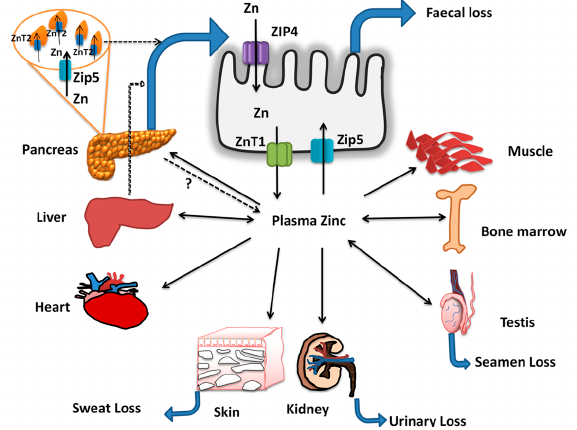
Figure 2. Zinc absorption and homeostasis: Dietary zinc and zinc excreted through pancreatic secretions are absorbed via ZIP4 at the apical surface of the enterocyte and are transported into circulation via ZnT1. The zinc in the plasma bound to albumin (major portion) or in free form is taken up by the peripheral tissues such as liver, bone marrow, testis, kidney, skin, heart, skeletal muscle, and pancreas. In the pancreas, ZIP5 sequesters the zinc from plasma, and it is incorporated in to zymogen granules via ZnT2 and excreted via pancreatic secretions. The absorbed zinc is lost through feces, urine, semen and sweat, among which fecal excretion is sensitive to zinc status of the host. In addition, during zinc insu ffi ciency, the plasma zinc levels are maintained via secretion of zinc only from specific tissues such as liver, bone marrow, and testes while it is strictly conserved in heart, skeletal muscle, skin, and kidney. Thus, enteric excretion of zinc via biliary-pancreatic axis maintains the zinc balance via modulation of excretion during repletion, while zinc depletion is countered via increased ZIP4 mediated absorption in the intestine. Further, during deficiency, few specific tissues release the zinc into the plasma (double arrows) and contribute to the maintenance of plasma zinc pool during inadequate intakes or